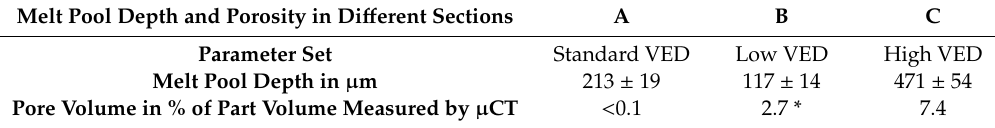
Figure 4. Light-microscopy of etched cross sections. Magnifications of the particular volumes A , B and C ; the white line indicates the melt pool borders of the topmost layer. Table 3. Quantitative measurements of melt pool depth and porosity percentage.